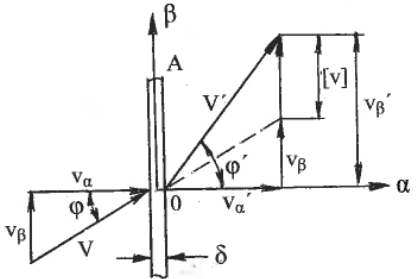
Figure 9. Simple shear along line of velocity discontinuity.